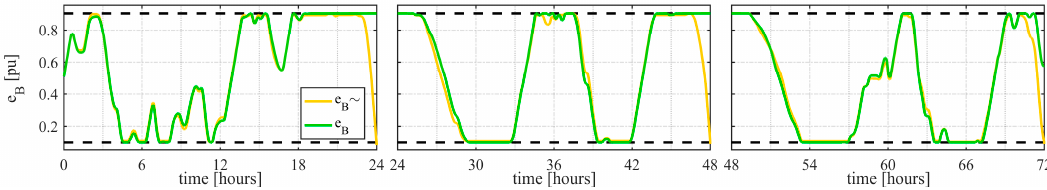
Figure 8. The B energy evolution achieved by OPEM over three days: ẽ B (orange, forecast at the start of each day) and e B (green, actual evolution).